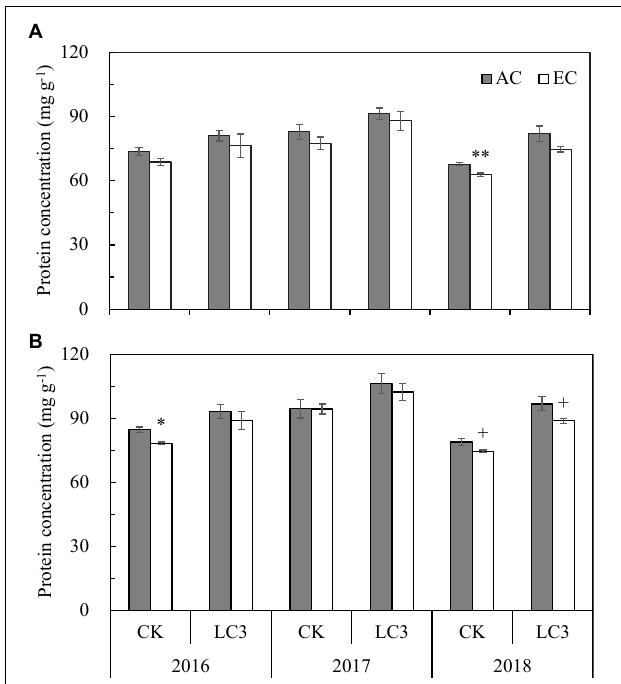
FIGURE 3 | The protein concentration in milled rice (A) and brown rice (B) of WYJ27 as affected by elevated CO 2 under CK (no leaf cutting) and LC (cutting off top three leaves) across three cropping seasons (2016–2018). Each bar in the figure represents the mean values across three plots for ambient CO 2 (AC, filled square) or elevated CO 2 (EC, AC + 200 ppm, unfilled square); vertical bars represent standard error ( n = 3). Statistically significant effects are indicated as ∗∗ P < 0.01; ∗ P < 0.05; + P <